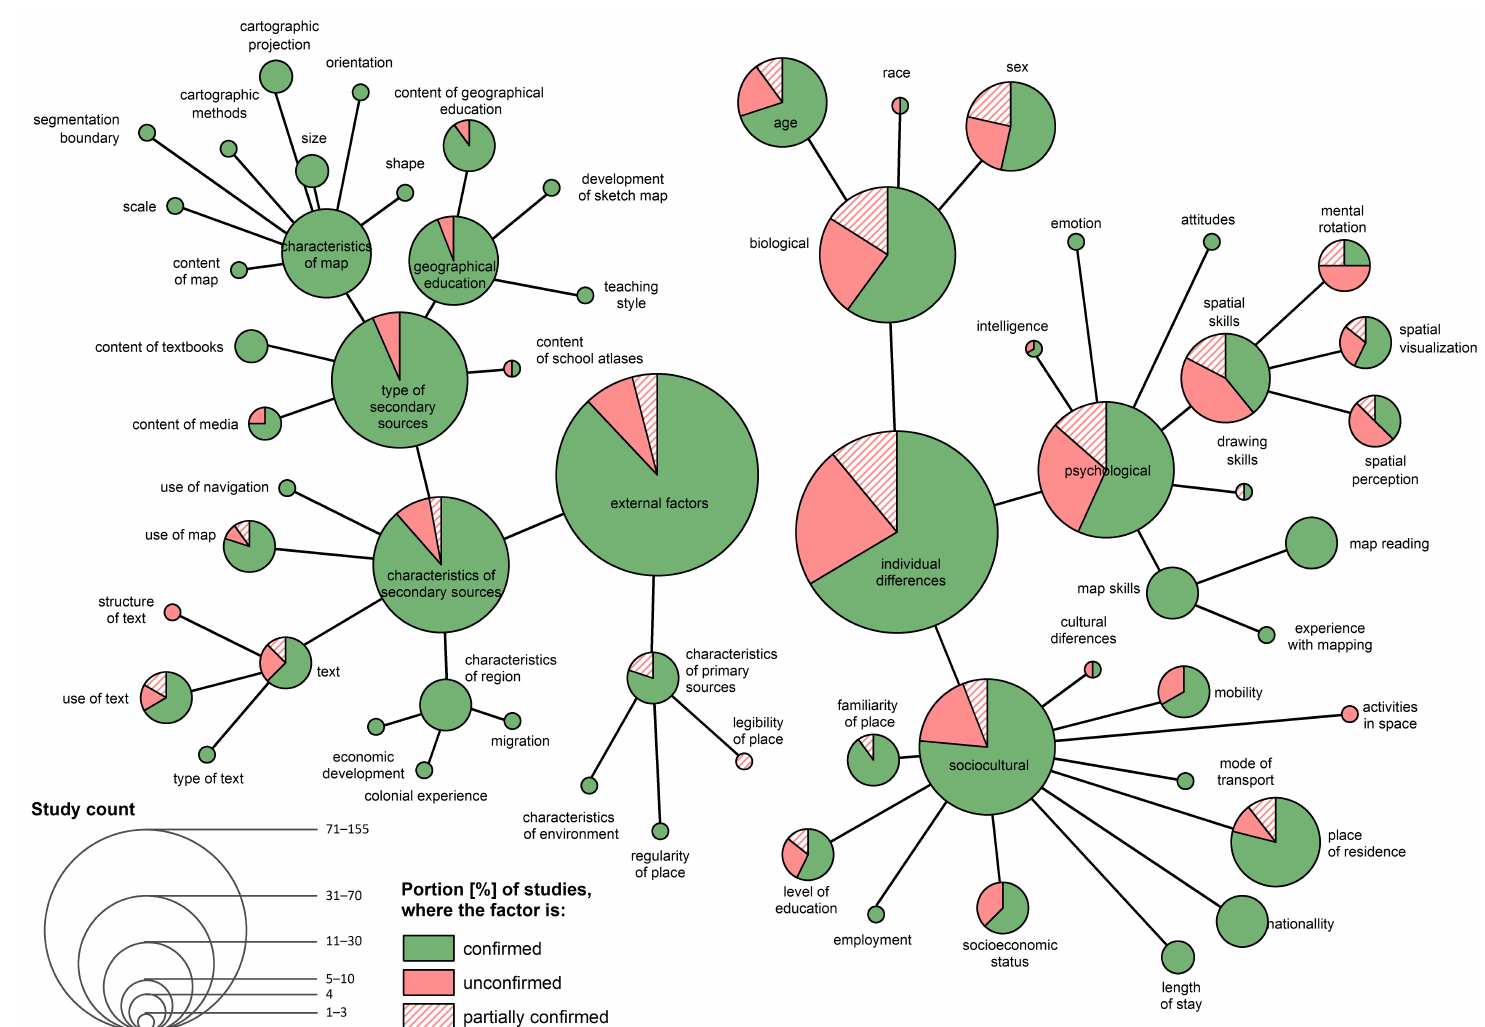
Figure 6. Factors influencing the overall quality of a sketch